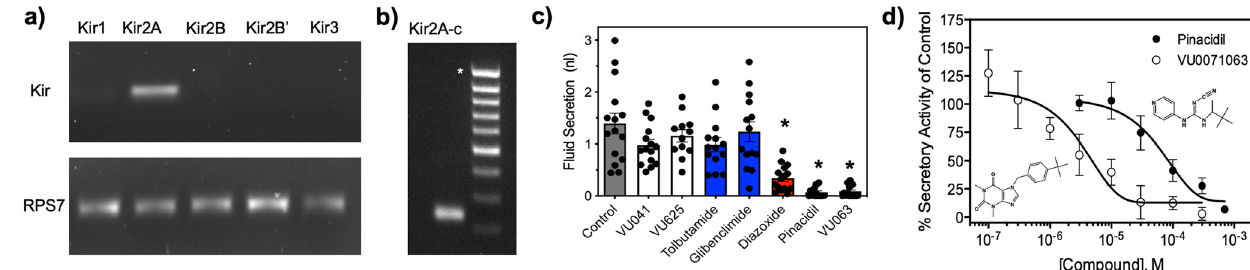
Fig. 2 In fl uence of Kir channel modulators to saliva secretion. a Relative expression of Ae Kir channel genes in the salivary gland with the sole band representing cumulative Ae Kir2A expression (all splices) relative to RPS7. b Relative expression of Ae Kir2A splice variants in mosquito salivary glands as determined by semi-quantitative RT-PCR. Asterisk represents 1000 bp on the Thermo Scienti fi c MassRuler DNA Ladder. c Total volume of secreted fl uid after PBS injection (control) or after injection of Kir modulators. Bars represent mean ( n = 15) volume secreted with error bars representing SEM. Statistical signi fi cance is denoted by the presence of an asterisk where * P < 0.05. d Concentration-response curve of pinacidil and VU0071063 in fl uence to fl uid secretion of adult female A. aegypti . Data points represent mean ( n = 3) saliva secretion of control where each replicate consisted of 25 individuals. Insets show molecular structures of VU0071063 (left) and pinacidil (right). See Supplemental Data 2 for underlying